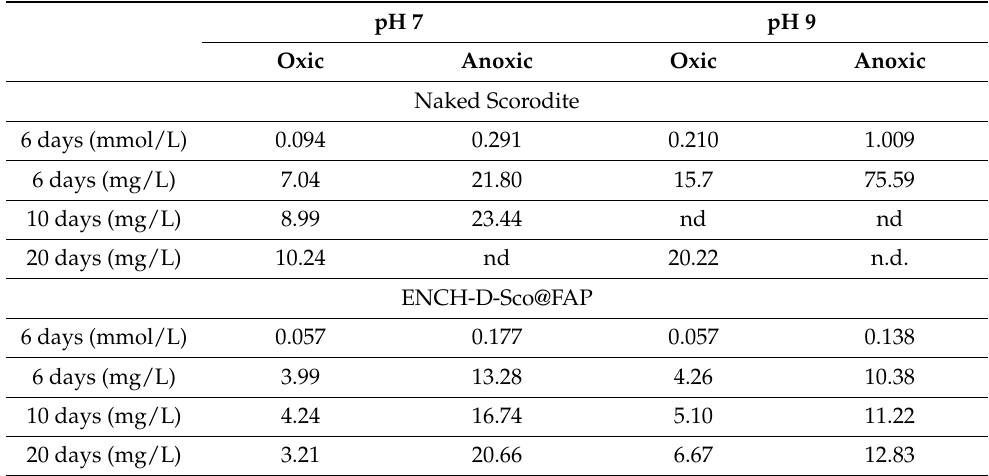
Table 1. Summary of released (mmol/L and in mg/L) data after 6 and 10 days in oxic (O) and anoxic (A, 200 ± 40 mV) environment at 22 ◦ C from naked scorodite and scorodite@FAP at different pHs. pH 7 pH 9 Oxic Anoxic Oxic Anoxic Naked